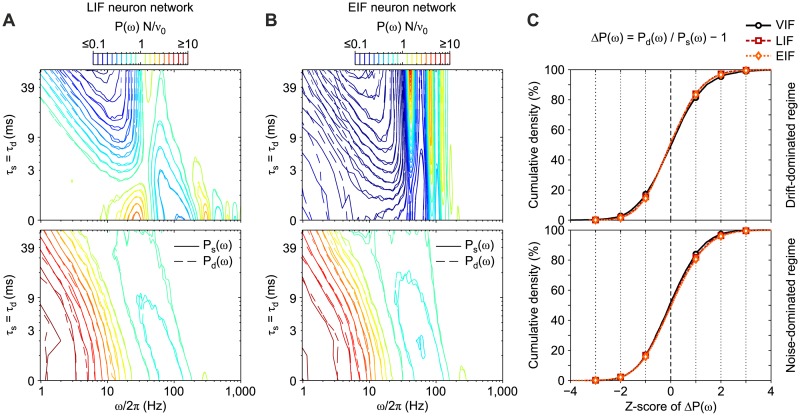
Equivalence between synaptic filtering and delay distribution in networks with different types of IF neurons.Match between relative power spectral densities P(ω)N/ν0 in networks of leaky (A) and exponential (B) integrate-and-fire excitatory neurons (LIF and EIF, respectively) with non-instantaneous synaptic transmission (solid lines) and distributions of synaptic delays (dashed lines). Network parameters are set in order to have an asynchronous state with average firing rate ν0 = 40 Hz. Contour lines as in Fig 6D. P(ω) are averages across 10 simulations with different random synaptic matrices and same mean-field parameters. (C) Cumulative distribution of relative differences ΔP(ω) = Pd(ω)/Ps(ω) − 1 across different time scales (τs and τd) and Fourier frequencies ω from panels A and B for LIF (red) and EIF (orange) neuron networks, respectively. As a reference, also the same cumulative distribution for VIF neuron networks (obtained from P(ω) in Fig 6D) is plotted (black). ΔP(ω) are measured as z-scores, i.e. averages divided by standard deviations of values across simulations. Top and bottom panels: networks working under drift-dominated and noise-dominated regime, respectively (see parameters in Tables 2 and 3).